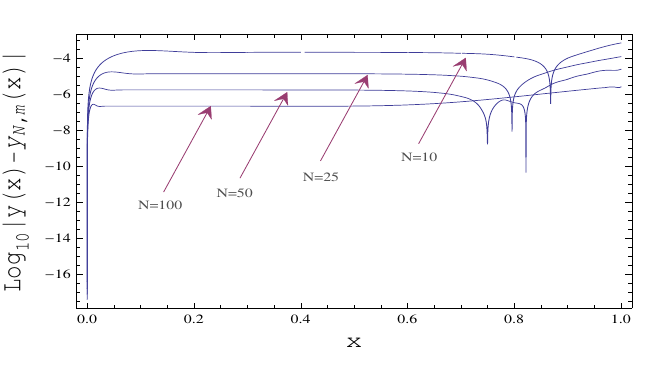
Figure 6. Absolute errors (in logarithmic scale) of approximations, for Example 3 with m=10 iterations and N = 10 , 25 , 50 , 100.